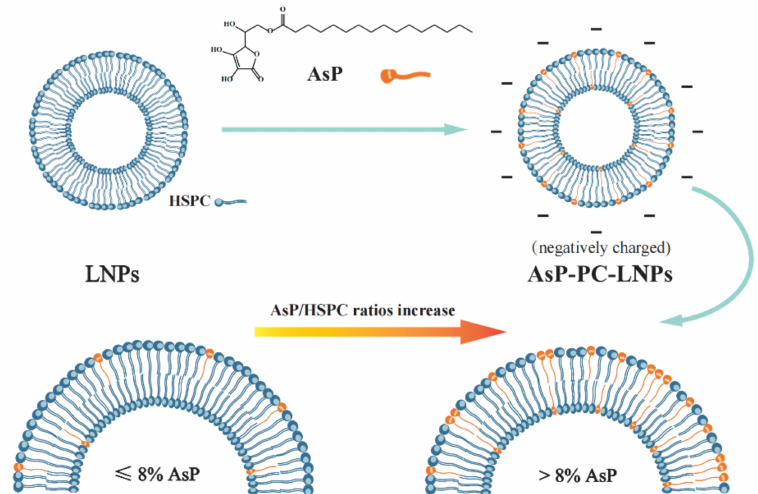
Figure 1. Schematic illustration of the mechanism of liposome surface charge modification by ascorbyl palmitate